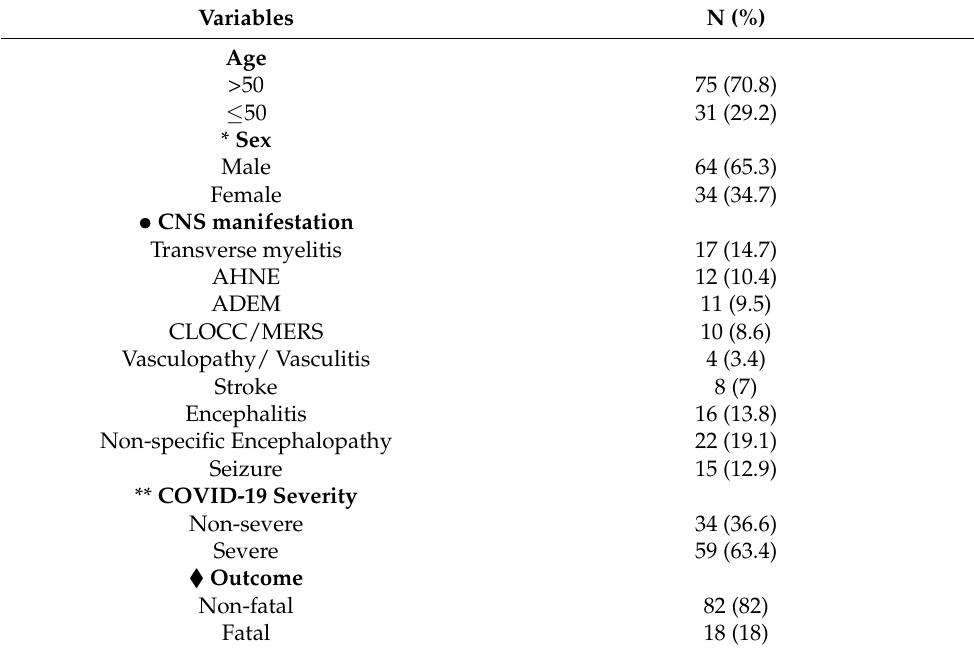
Table 1. Demographics and CNS manifestations in the 106 patients.